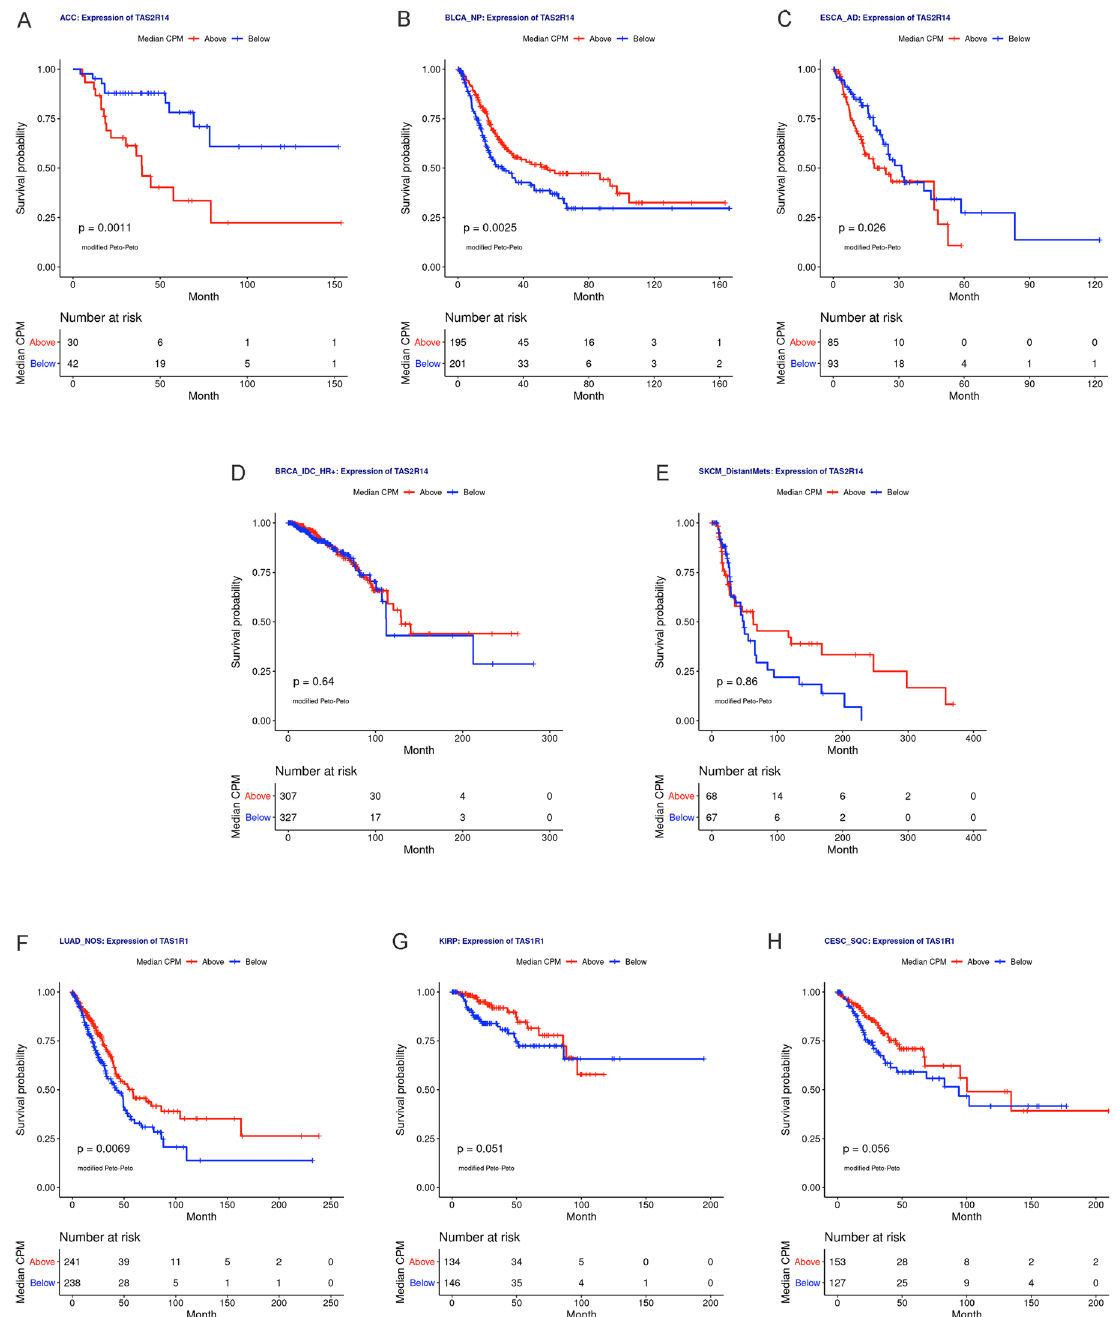
Figure 6. Bitter taste receptor TAS2R14 and umami receptor TAS1R1 expression are associated with survival in select solid tumors. ( A – E ) Kaplan–Meier curves for high and low expression groups for TAS2R14 in ( A ) adrenocortical cancer (ACC), ( B ) non-papillary bladder cancer (BLCA_NP), ( C ) esophageal adenocarcinoma (ESCA_AD), ( D ) hormone receptor positive infiltrating ductal breast carcinoma (BRCA_IDC_HR +), and ( E ) distantly metastatic skin melanoma (SKCM_DistantMets). Peto-Peto’s modified survival estimate was significant for TAS2R14 expression in ACC, BLCA_NP, ESCA_AD, and kidney clear cell carcinoma (KIRC; shown in Supplemental Fig. 5). ( F – H ) Kaplan–Meier survival curves for high and low expression groups for TAS1R1 in ( F ) lung adenocarcinoma (LUAD_NOS), ( G ) kidney papillary cell carcinoma (KIRP), and (H) cervical esophageal squamous cell carcinoma (CESC_SQC). Peto-Peto’s modified survival estimate was statistically significant for TAS1R1 expression in LUAD_NOS. ACC adrenocortical cancer; BLCA_NP non-papillary bladder cancer; BRCA_IDC_HR + hormone receptor positive infiltrating ductal carcinoma; CESC_SQC cervical esophageal squamous cell carcinoma; CPM counts per million; ESCA_AD esophageal adenocarcinoma; KIRC kidney clear cell carcinoma; KIRP kidney papillary cell carcinoma; LUAD_NOS lung adenocarcinoma; SKCM_ DistantMets distantly metastatic skin